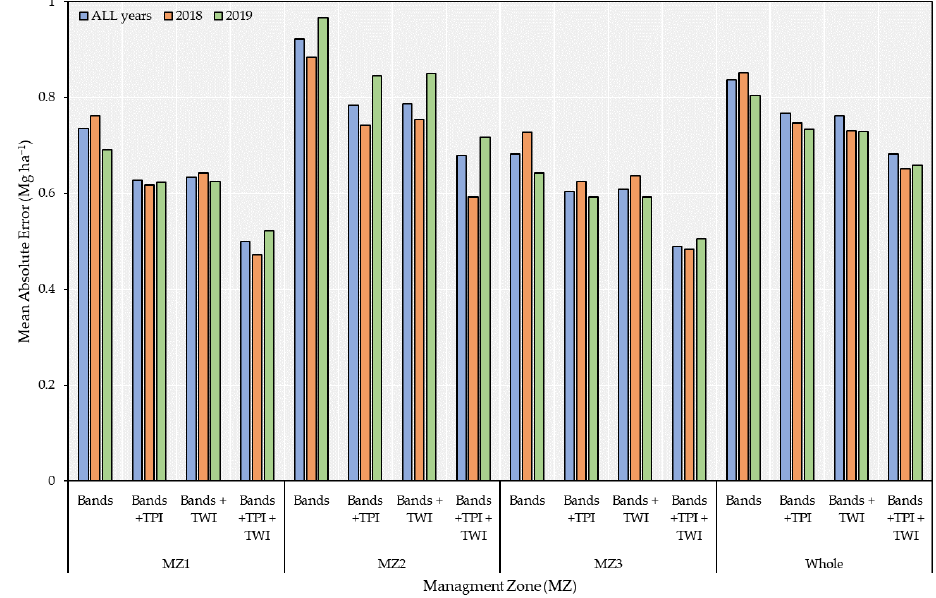
Figure 7. Accuracy (MAE) of the validation phase for models developed for isolated management zones and for whole field using several features (spectral bands and topographic indices) in three scenarios (2018, 2019, and all years combined).